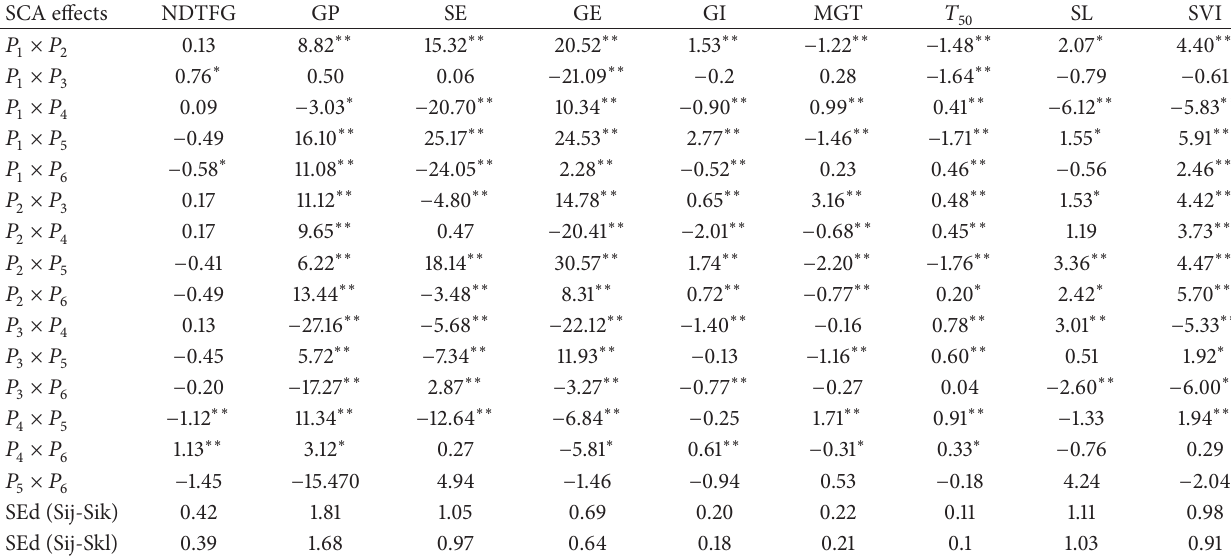
Table 4: SCA effects for nine germination traits of 6 × 6 diallel populations in Jatropha curcas . SCA